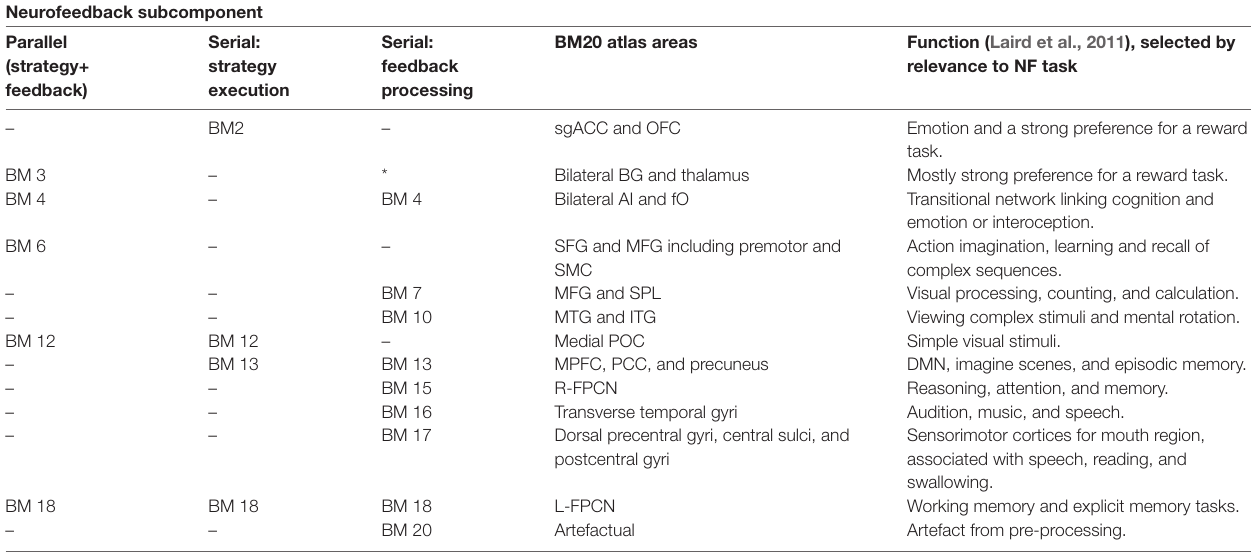
TABLE 2 | Prominent BrainMap20 intrinsic connectivity networks that are spatially correlated to activation maps in the neurofeedback subcomponents in the three conditions. Neurofeedback